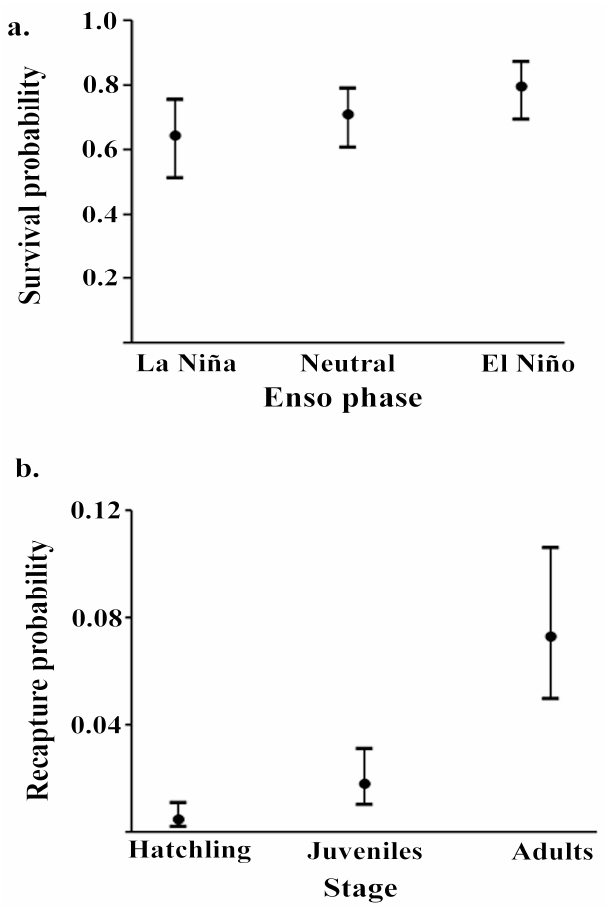
Figure 2. ( a ) ENSO phase survival probability, and ( b ) stage-specific recapture probability for the Chocoan River Turtle on Isla Palma estimated using multi-state mark-recapture models (error bars = 95% confidence interval).